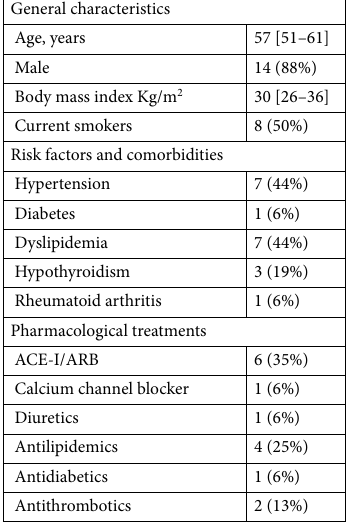
Table 1. Characteristics of the enrolled population (total number of subjects = 16). ACE-I = angiotensin- converting enzyme inhibitor; ARB = angiotensin receptor blocker; Data are presented as absolute number (%) or median [interquartile range].